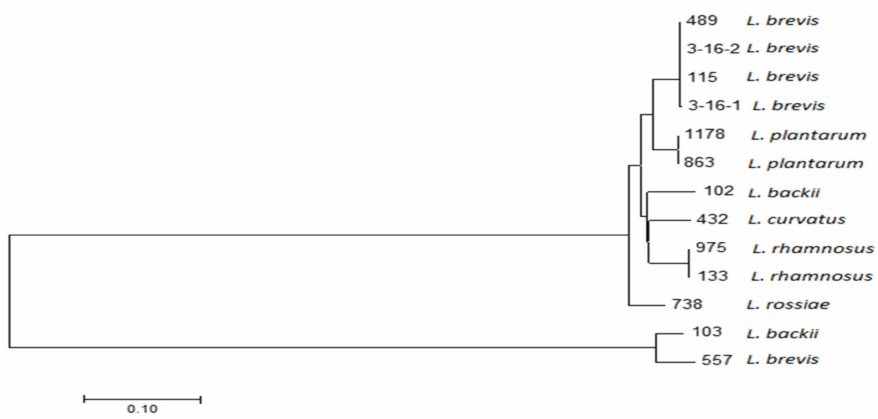
Figure 1. Phylogenetic tree based on the 16S rDNA sequences of the studied Lactobacillus strains. The neighbor-joining method was used to compute the evolutionary distances. The tree is drawn to scale, with the branch lengths measured in the number of substitutions per site. The tree was obtained using the MEGA7 software.